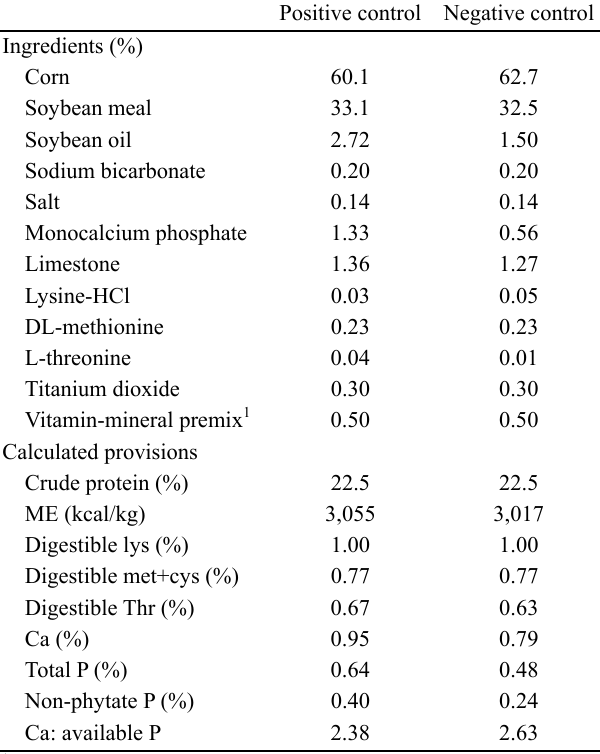
Table 1. Composition of the control diets, as